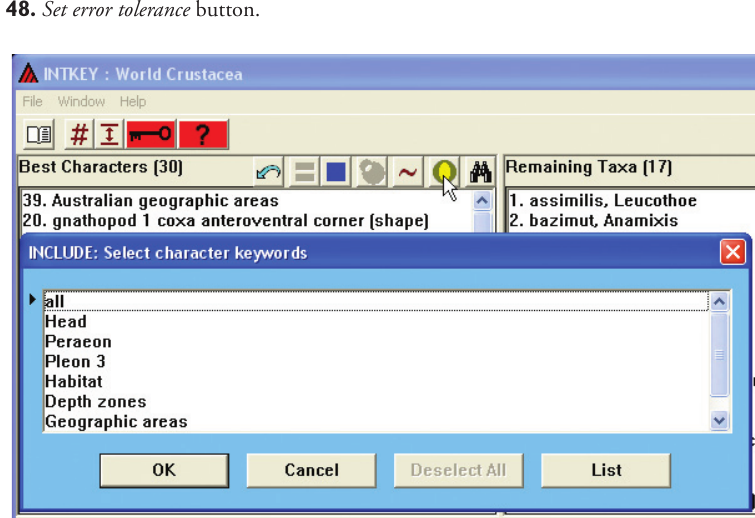
Figure 49. Use a subset of characters